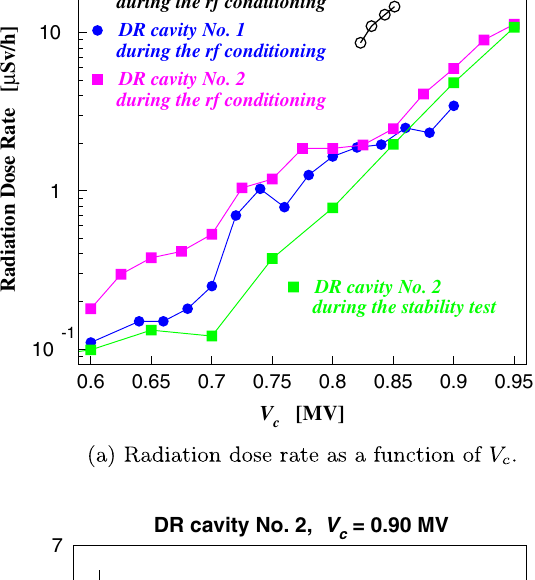
FIG. 18. (a) Fraction of spot-type explosion events with an explosion spot in each quadrant of the FEP (blue squares) and TEP (magenta circles), where the binomial errors are shown with a 1 σ confidence interval. Quadrants Q 1 , Q 2 , Q 3 , and Q 4 are defined in Fig. 17. A fraction of 0.25 (perfect uniformity) is shown by the dashed line. (b) Statistical significance of the deviation from perfect uniformity.